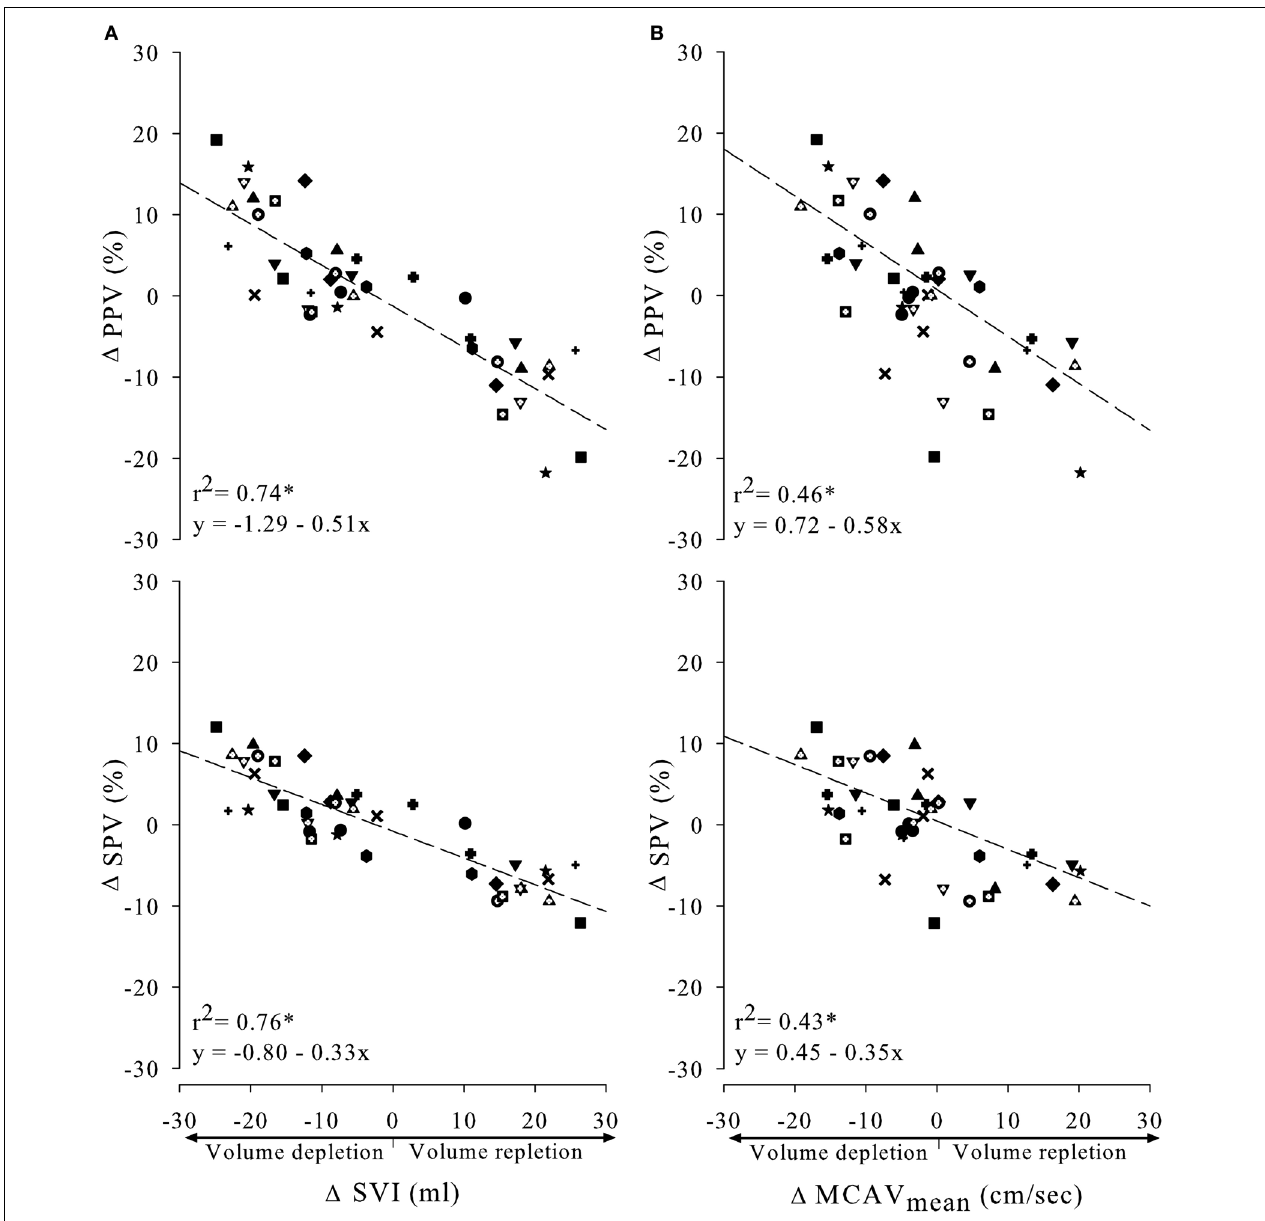
indicated by symbols and contributed three points in each regression line (during 30 and 70 degrees HUT + 0 degrees during tilt back). ∗ p < 0 .